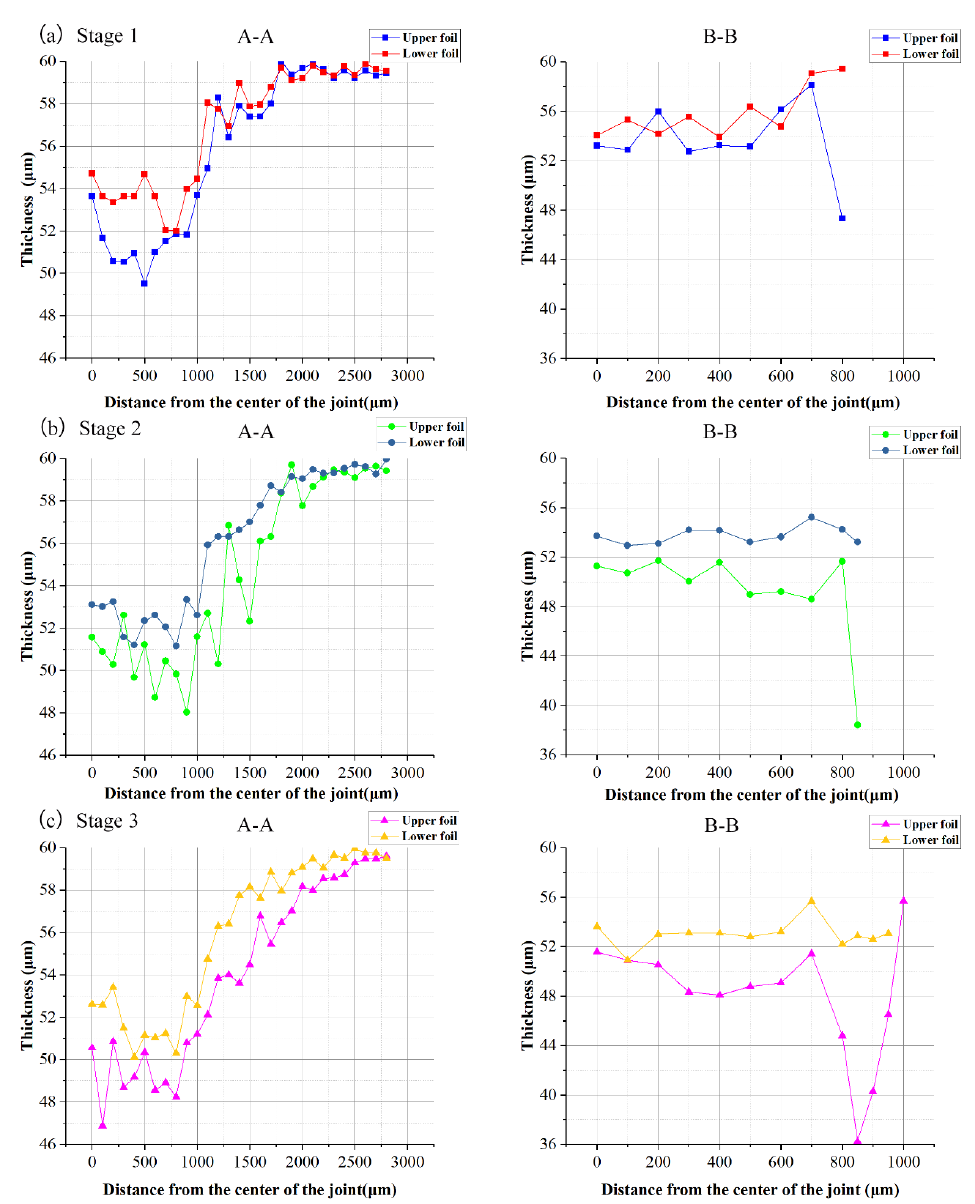
Figure 16. Thickness distribution comparisons of upper and lower foils: ( a ) Stage 1; ( b ) Stage 2; ( c ) Stage 3.